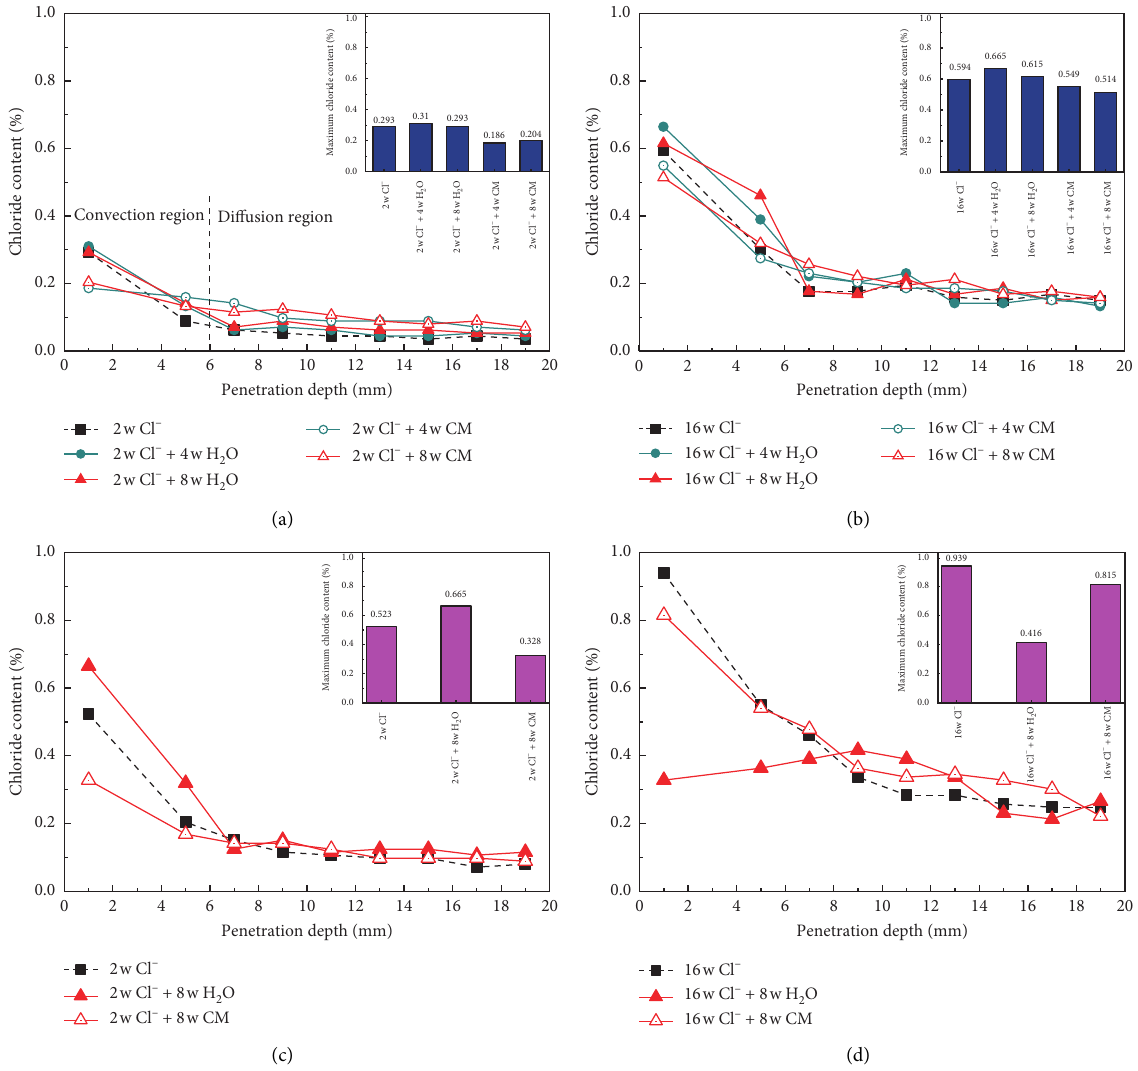
Figure 11: Curves of chloride content by convection and concentration gradient. (a) After 2-week chloride attack (w/c � 0.4), (b) after 16- week chloride attack (w/c � 0.4), (c) after 2-week chloride attack (w/c � 0.6), and (d) after 16-week chloride attack (w/c � 0.6). “2 w Cl − ” represents that chloride content was immediately determined after 2-week chloride attack (control group); “2w Cl − +8 w CM” presents that the concrete was first subjected to the chloride attack for 2 weeks, and then all the surfaces were sealed and standing for 8 weeks, and in this case, chloride migration (CM) was by the concentration